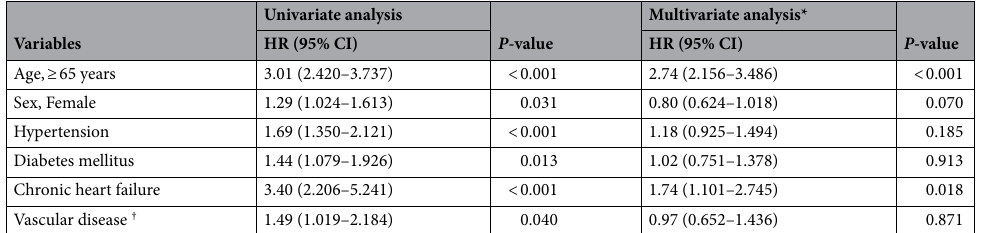
Table 2. Cox regression analysis for the risk of ischemic stroke in patients with hypertrophic cardiomyopathy without documented atrial fibrillation. CI confidence interval, HR hazard ratio. *Adjusted for age, sex, low income, chronic heart failure, hypertension, diabetes mellitus, dyslipidemia, vascular disease (including myocardial infarction and peripheral artery disease), and pacemaker implantation. † Vascular disease included myocardial infarction and peripheral artery disease.